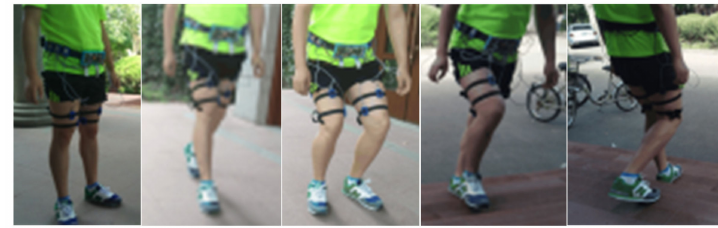
Figure 6. Subject wears EMG acquisition equipment to exercise